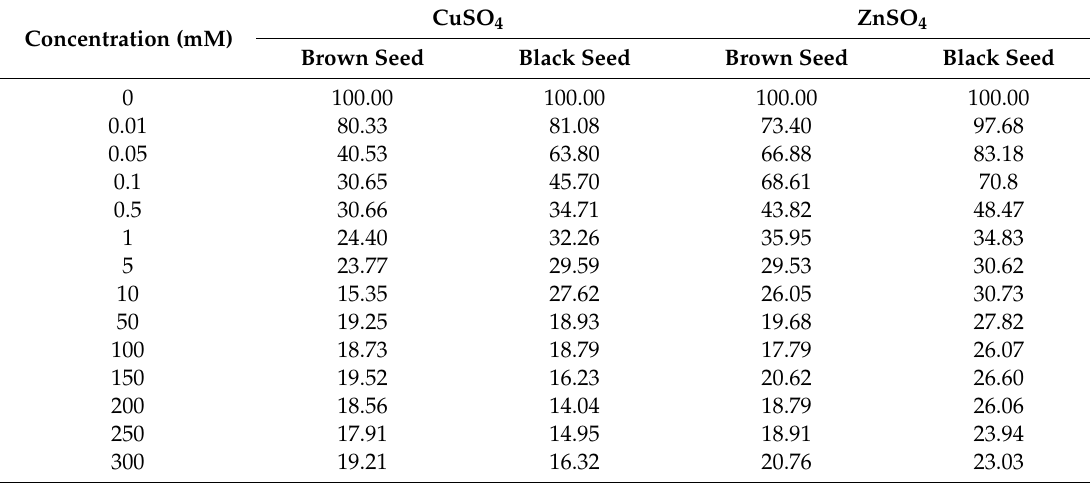
Table 4. E ff ect of CuSO 4 and ZnSO 4 on the radicle tolerance index of S. salsa seedlings grown from brown and black seeds.